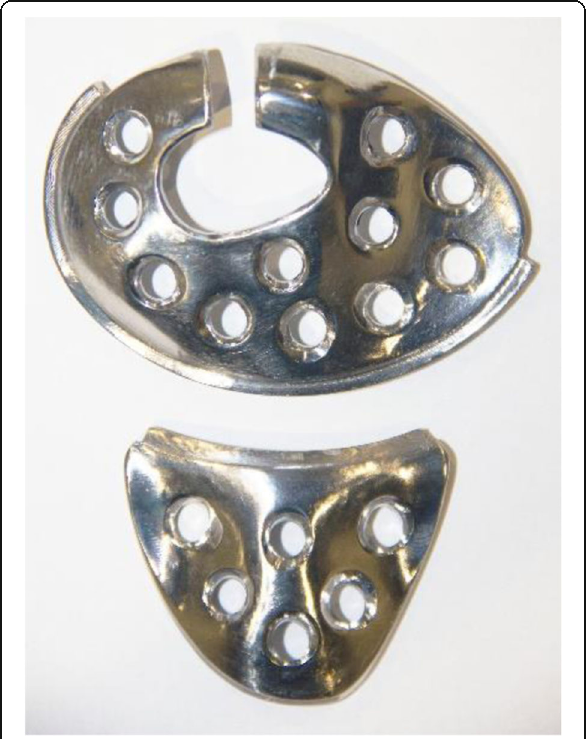
Fig. 3 A prototype of the implant manufactured by CNC machining. (Upper part is the femoral component of the implant, and lower one is the tibial component) Fig. 4 Embalmed specimen No.